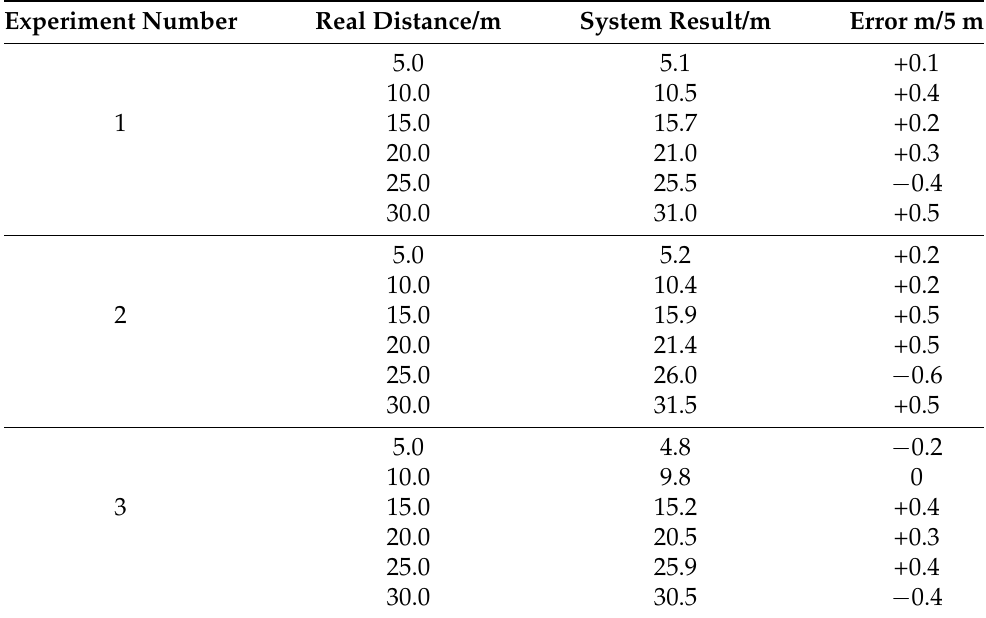
Table 6. Movement distance measurement